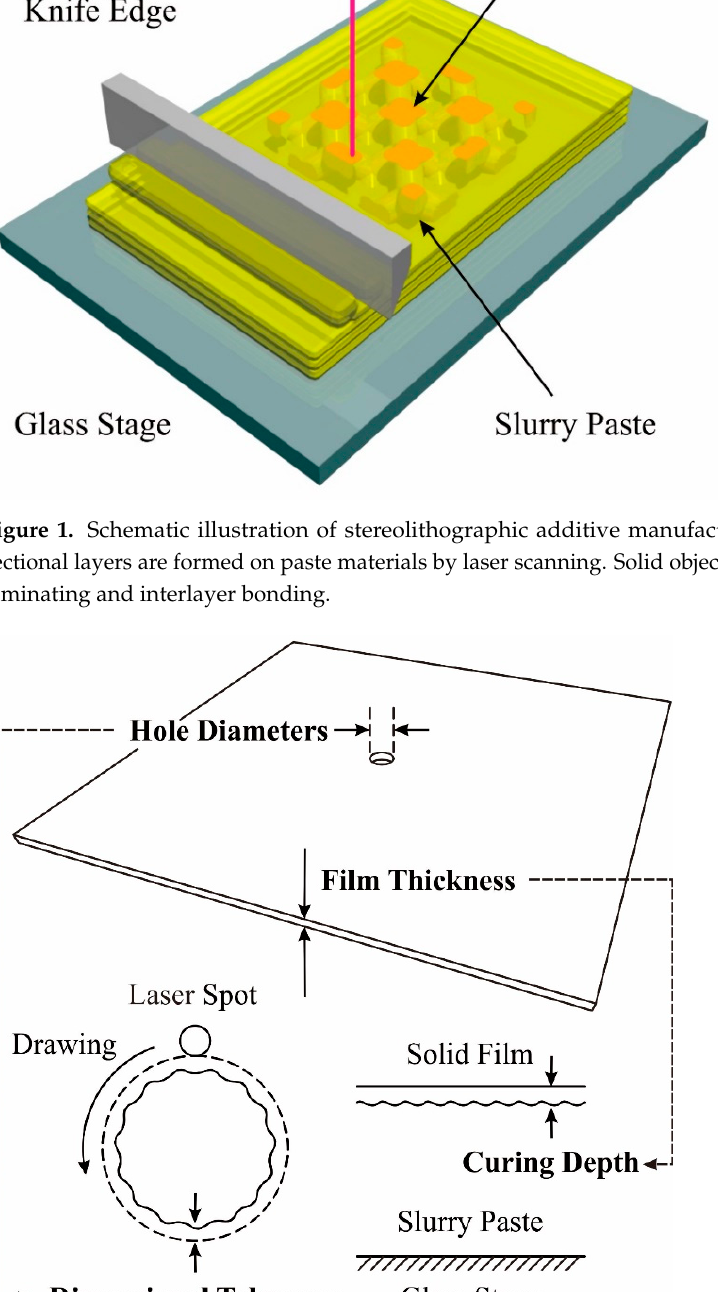
Figure 2. Drawing pattern of film specimens to optimize lithographic conditions. Hole diameters and layer thicknesses were measured by a digital optical microscope. Dimensional tolerances and curing depth were estimated.